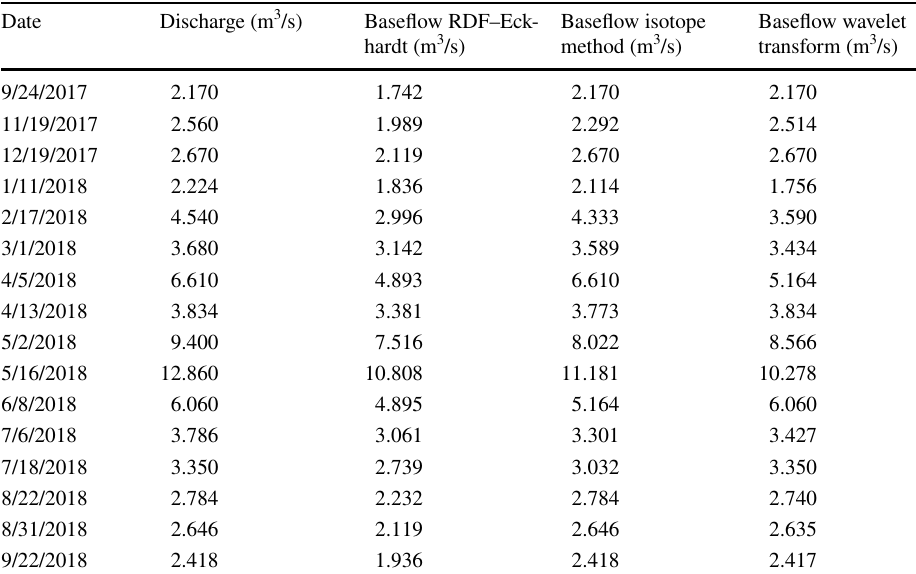
Fig. 7 Comparison of used methods of baseflow separation in the period